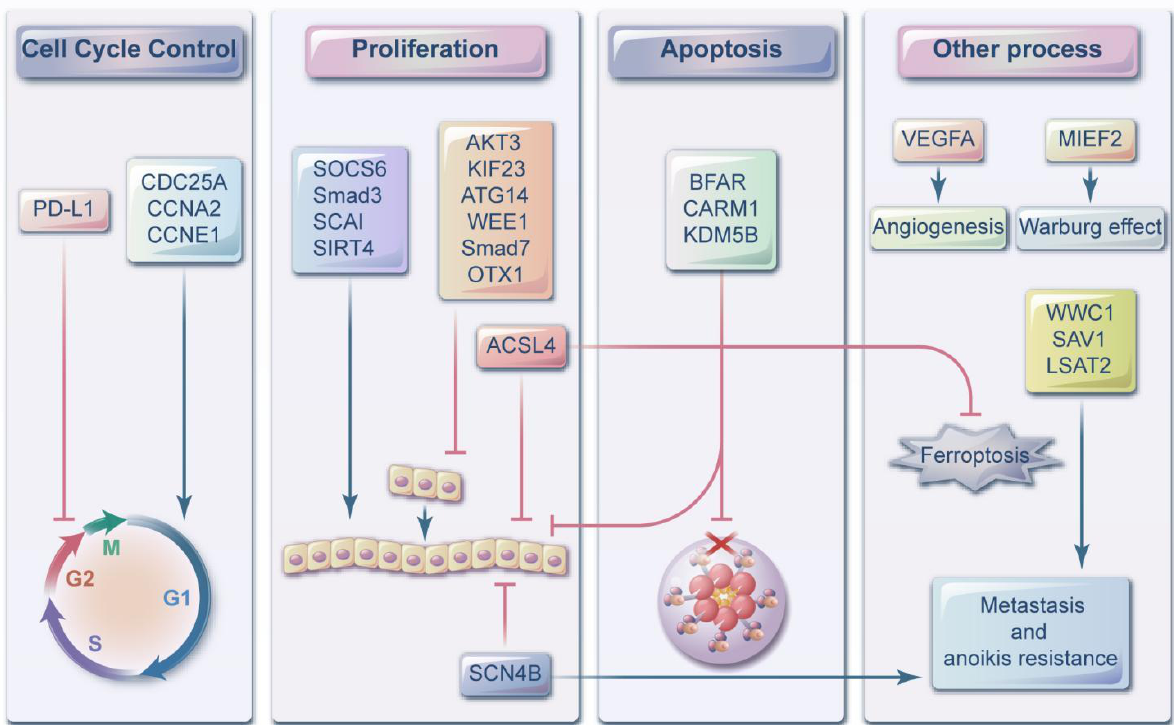
Figure 1. The ways that miR-424-5p regulates cancer cell progression can be categorized into 4 mechanisms. (i) By controlling cell cycle. (ii) By promoting or inhibiting cancer cell proliferation, (iii) By regulating tumor cell apoptosis (iv) By acting on the processes that cancer cells have, such as the Warburg effect, metastasis, anoikis resistance, ferroptosis and angiogenesis. The targets of miR-424-5p can not only participate in one ways, but can have different roles in different mechanisms.